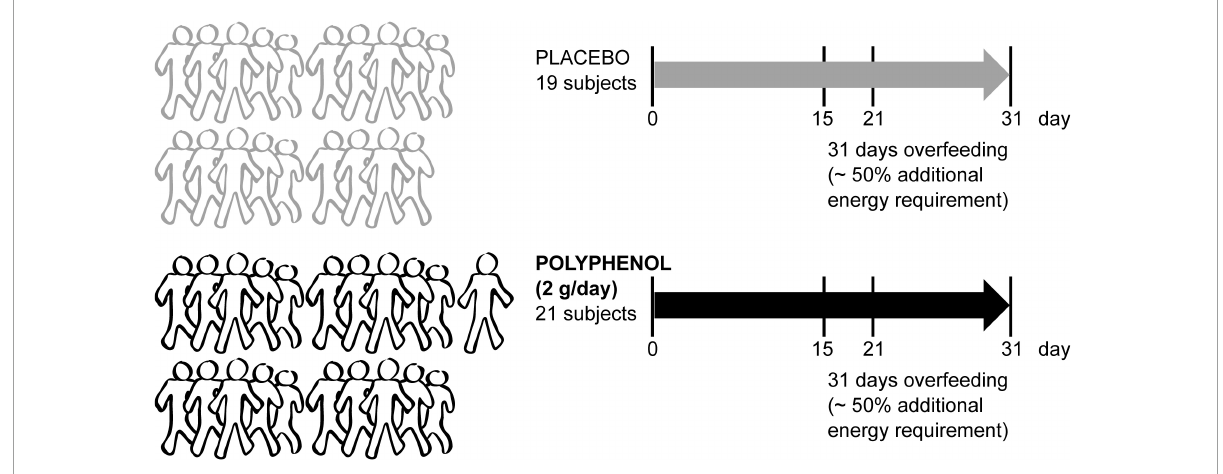
FIGURE1 Metabolomics blood sample analysis of the male “Lyon” human clinical intervention. Forty-two sedentary male adult subjects were recruited to a randomized parallel-controlled trial where all subjects were submitted to an overfeeding intervention for 31 days with ∼ 50% additional energy requirement. Half of the subjects took a placebo, while the rest were given 2 g/day of polyphenol-rich grape extract. The fasting blood collection days are indicated (0, 15, 21, and 31 days). Plasma metabolomics was performed in samples from 40 subjects (19 placebo and 21